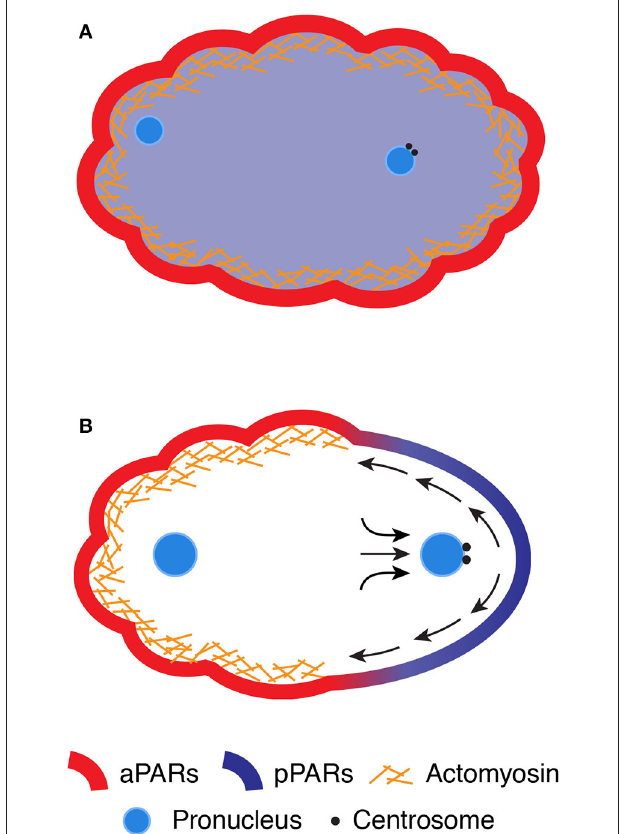
FIGURE 1 | SB in the C. elegans zygote. (A) The cell cortex enriches of the contractile actomyosin network, which exhibits dynamic cycles of contraction and relaxation, whereas the maternal and paternal chromosomes decondense into pronuclei in the cytoplasm. The aPARs are distributed evenly along the cortex, whereas the pPARs are localized throughout the cytoplasm. (B) While the paternal pronucleus approaches the posterior pole, centrosomes send unknown signals to the cortex to initiate SB. The contractile actomyosin network and aPARs are segregated toward the anterior pole via cortical flow, whereas the pPARs are translocated from the cytoplasm to the smoothing posterior pole of the zygote.